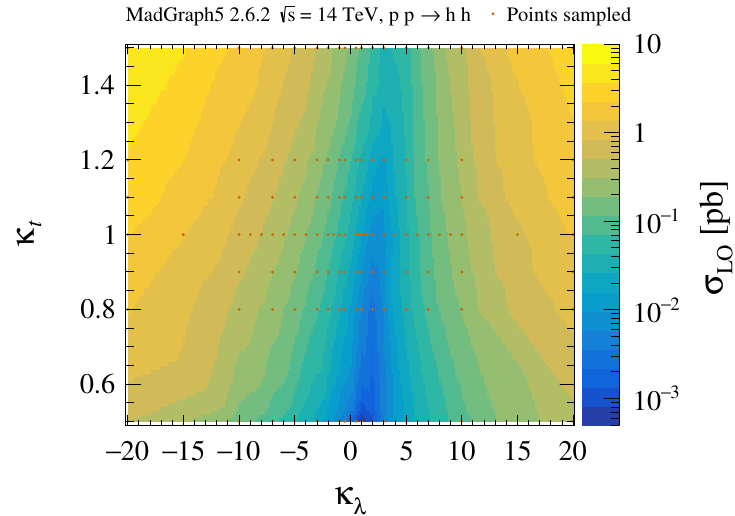
Figure 2. Leading order cross-sections σ LO from MadGraph [112, 113] as a function of the variation of Higgs trilinear self-coupling κ λ and top Yukawa coupling κ t from their SM values λ SM , y SM using the HeavyHiggsTHDM model [114]. The orange markers indicate the points t hhh sampled from this parameter